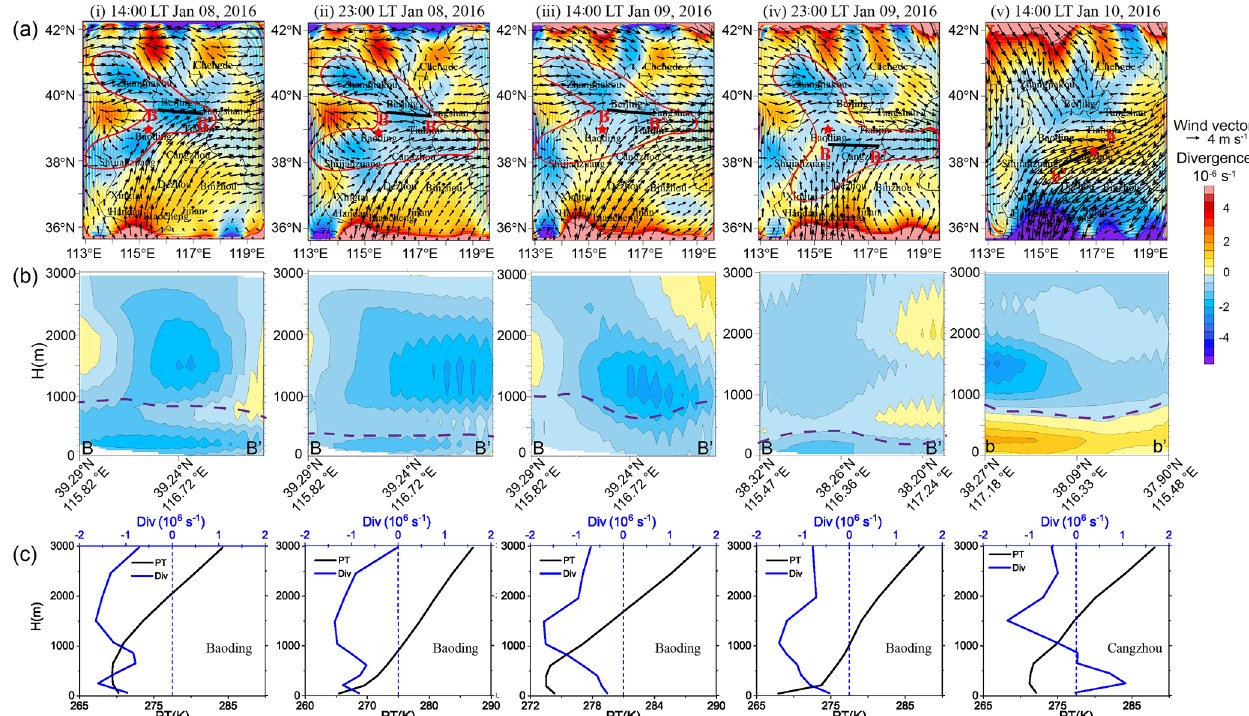
Figure 9. Same as Fig. 8, but for representative case 2 under south–north wind shear mode. The red lying-Y shapes, black lines, and red stars in (a) indicate the convergence belt, the section lines in (b) , and the profile sites in (c) , respectively. The dashed purple lines in (b) indicate the PBL heights. The potential temperature profiles are presented in (c) to indicate the boundary layer top at the representative